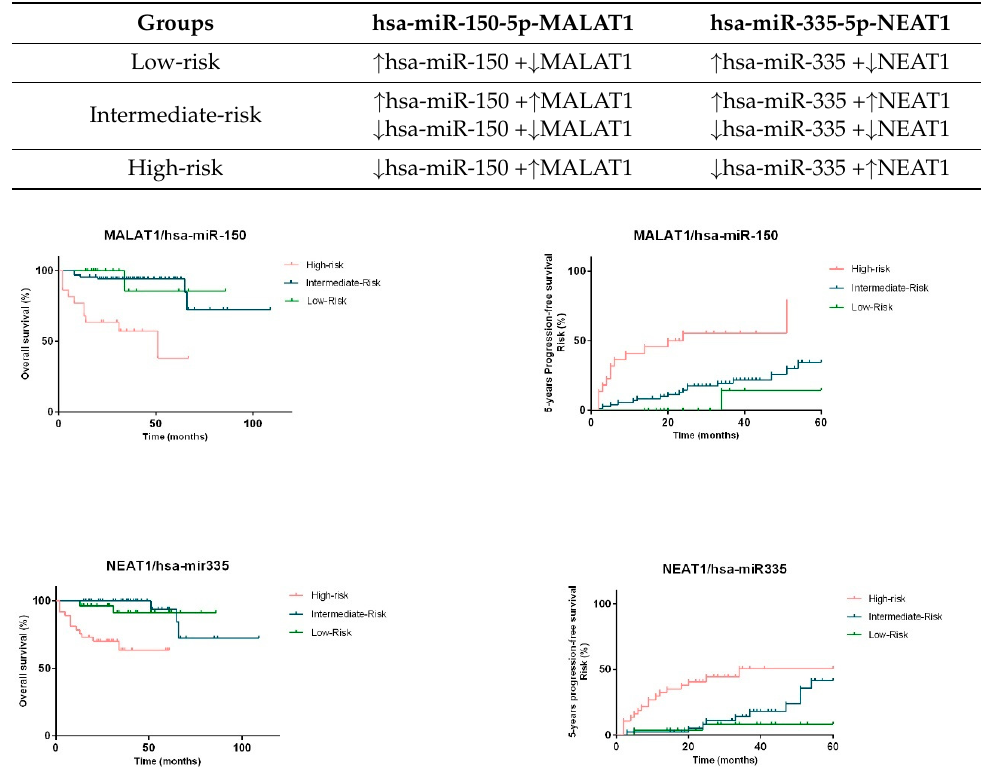
Figure 8. OS and PFS of NHL patients according to plasma levels of miRNA/lncRNA pairs ( p < 0.001). Multivariate analysis was conducted with significant clinical parameters associated with patients’ prognosis and revealed that low expression of hsa-miR-150-5p and high expression of MALAT1 were independent poor prognostic factors of OS and PFS (OS: p = 0.020 and p = 0.026; PFS: p = 0.027 and p = 0.021, respectively) (Supplementary Table S2). Similarly, regarding the hsa-miR-335-5p-NEAT1 ceRNA pair, low levels of hsa-miR-335-5p and high levels of MALAT1 were observed to be also independent poor prognostic factors of OS and PFS (OS: p = 0.037 and p = 0.002; PFS: p = 0.009 and p = 0.040, respectively) (Supplementary Table S3). Patients with low hsa-miR-150-5p/high MALAT1 and low hsa-miR-335-5p levels/high NEAT1 levels present a higher risk of death and disease progression compared to patients with high levels of hsa-miR-150-5p/low levels MALAT1 and high levels of hsa-miR-335-5p/low levels